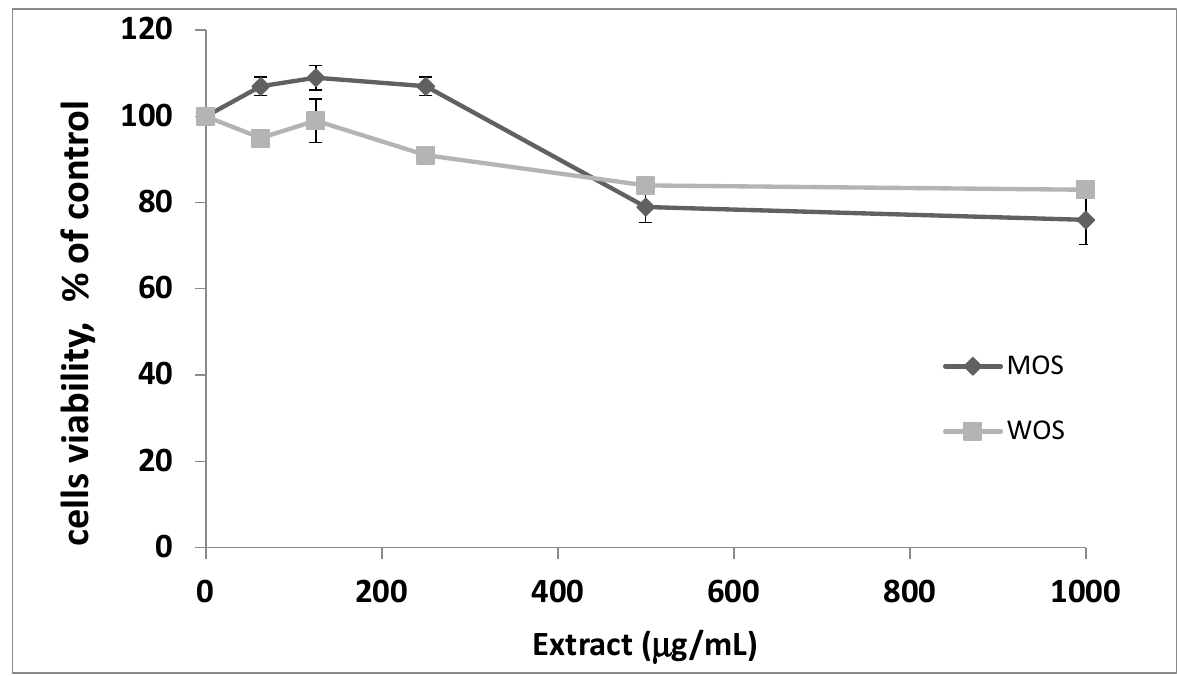
Figure 1. Effect of O. stamineus methanol (MOS) and water (WOS) extract on cell viability examined by MTT assay. L6-GLUT4myc cells (20,000 cell/well) were seeded in 96-well plate and were exposed to the extract for 24 h. Values given represent means ± SEM (% of untreated control cells) of three independent experiments carried out in triplicates.